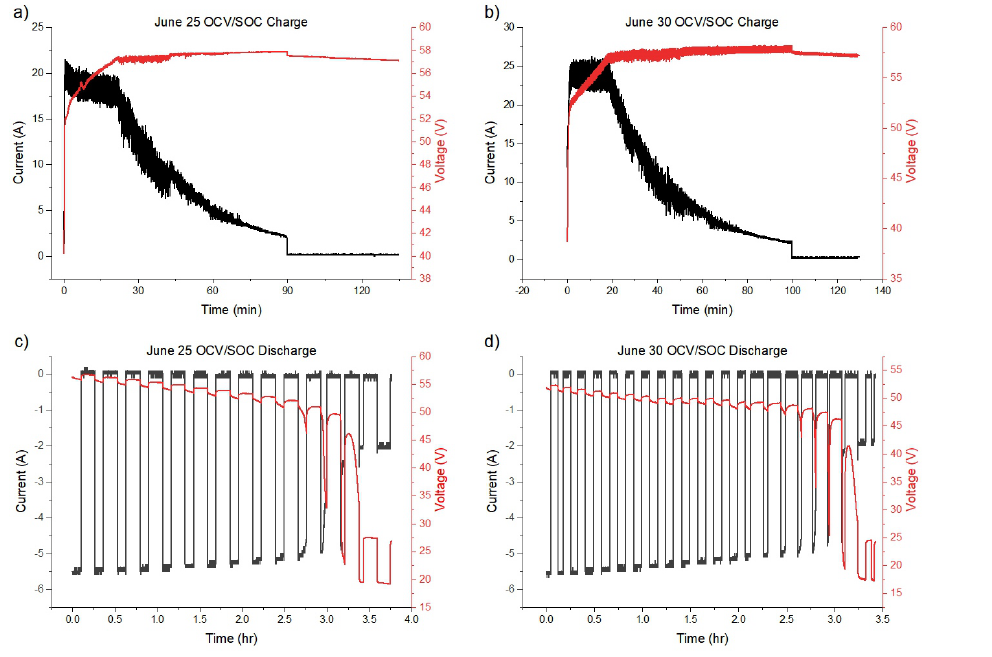
Figure A2. OCV-SOC test performed with 40 L of electrolyte and an automatic rebalancing tube. Charge current/voltage using ( a ) 20 A and ( b ) 25 A max charge currents. Discharge current/voltage after using a ( c ) 20 A and ( d ) 25 A max charge current